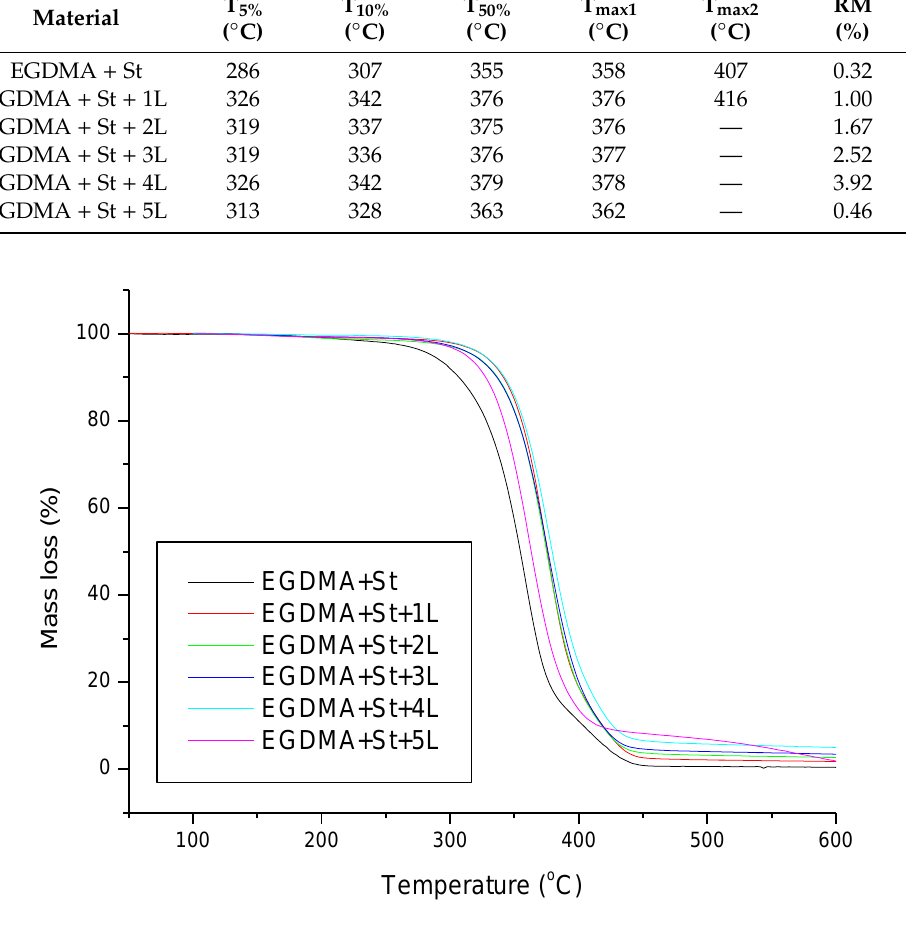
Figure 9. Thermogravimetry curves of the obtained materials.